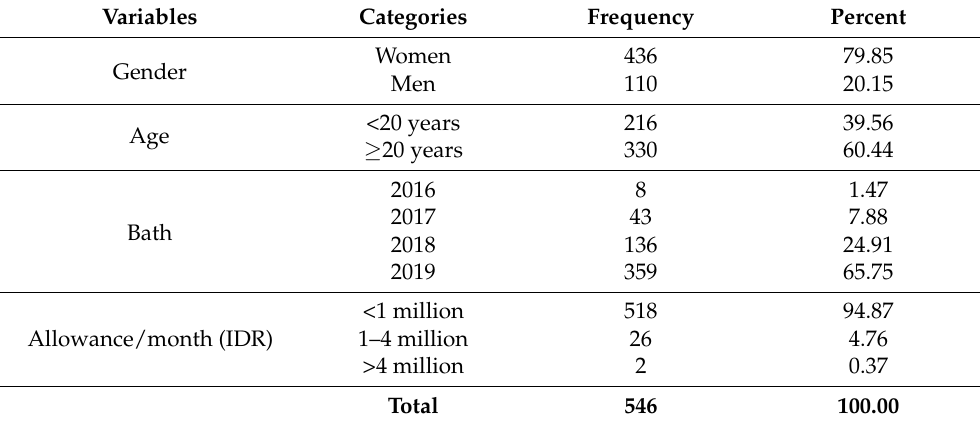
Table 1. Descriptive of respondent profile.